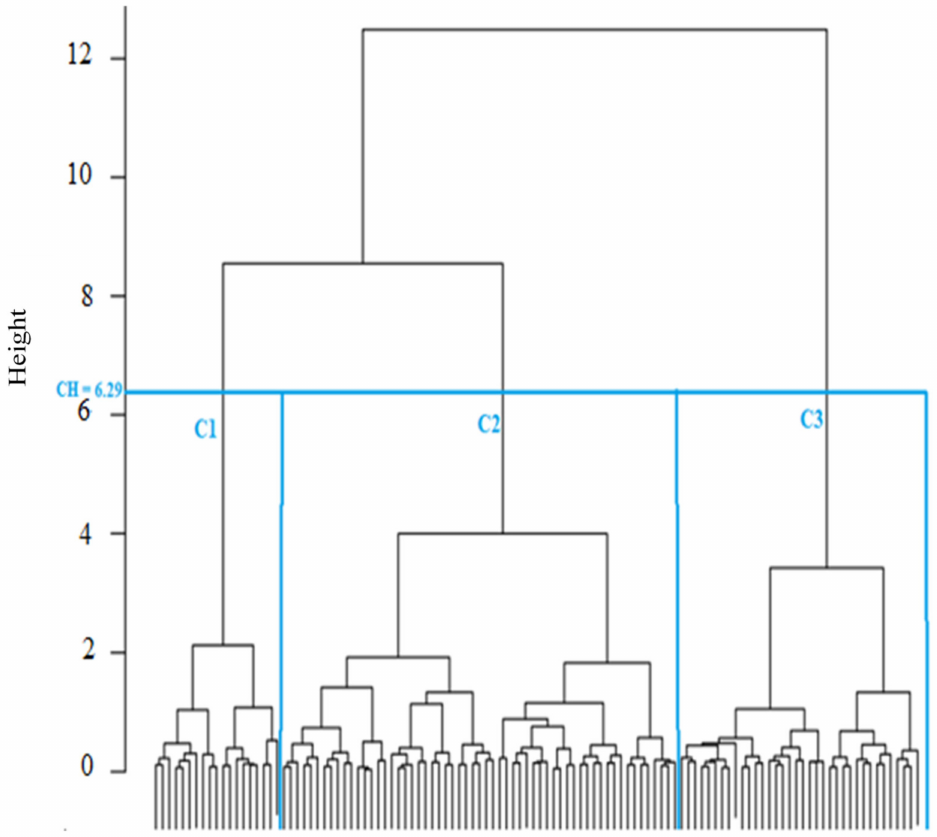
Figure 13. Dendrogram obtained using a hierarchical ascending classification; CH—cut-off height; C1—weakly metamorphosed, C2—moderately metamorphosed, and C3—strongly